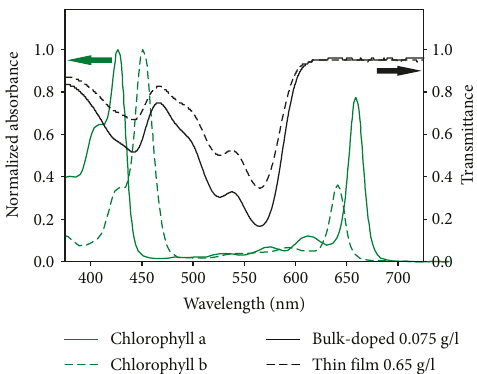
Figure 9: Waveguide transmittance and normalized absorbance of chlorophylls a and b in diethyl ether. Waveguides of both devices primarily concentrate wavelengths between 500 and 600nm and transmit the majority of the light absorbed by the two primary plant pigments. The optimized thin- fi lm LSC transmits more light due to its lower optical density. Absorbance measurements were taken from Lichtenthaler